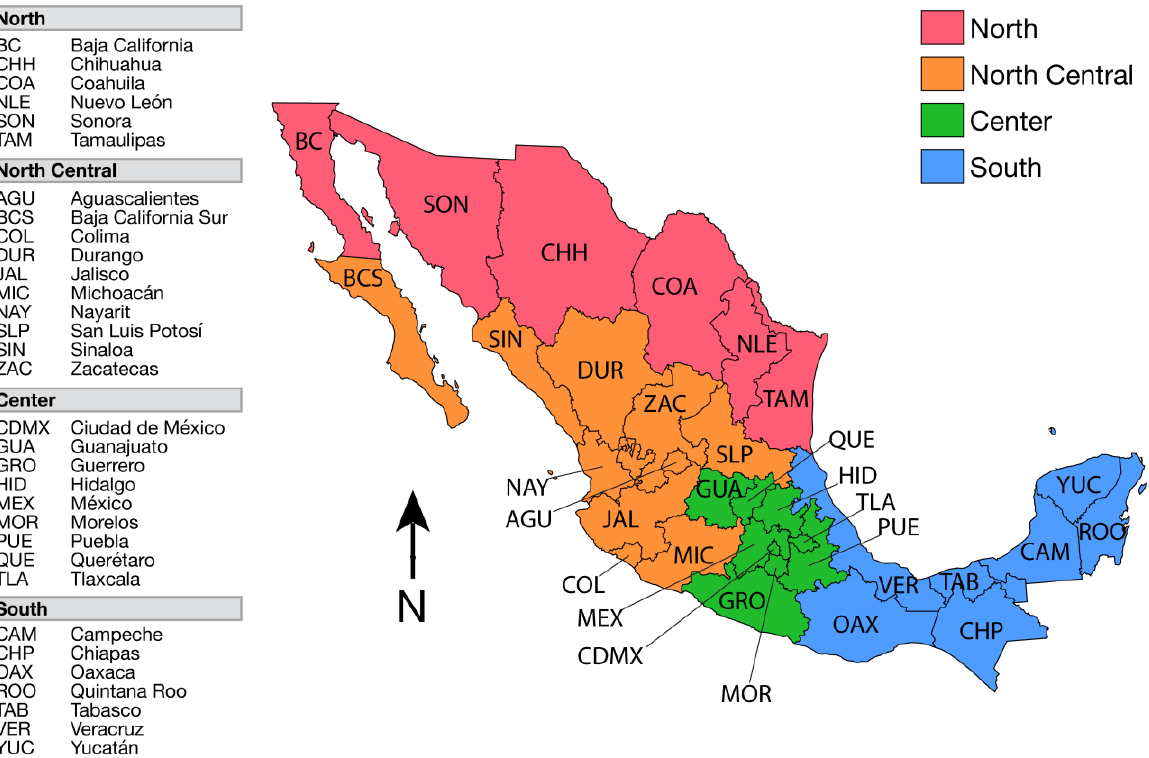
Figure 5. States and regions of